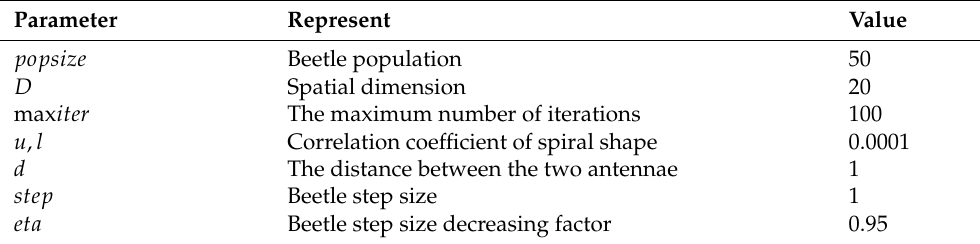
Figure 17. Flowchart of test experiment. Table 3. Experimental parameter